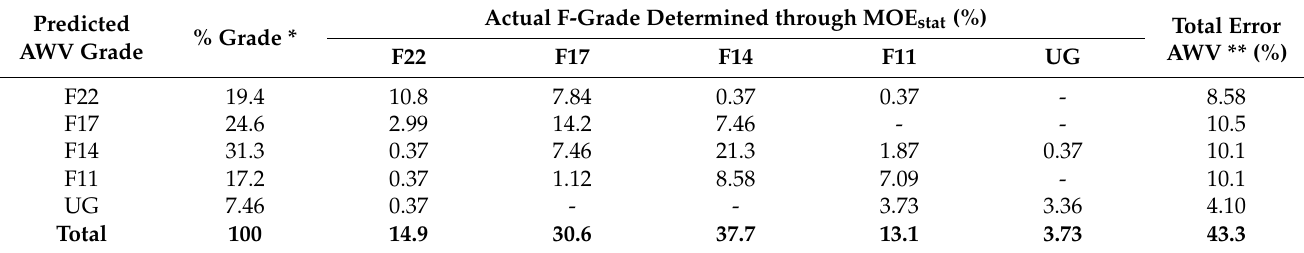
Table 7. Classification of boards via the equation developed through AWV and relative error. Predicted AWV Grade